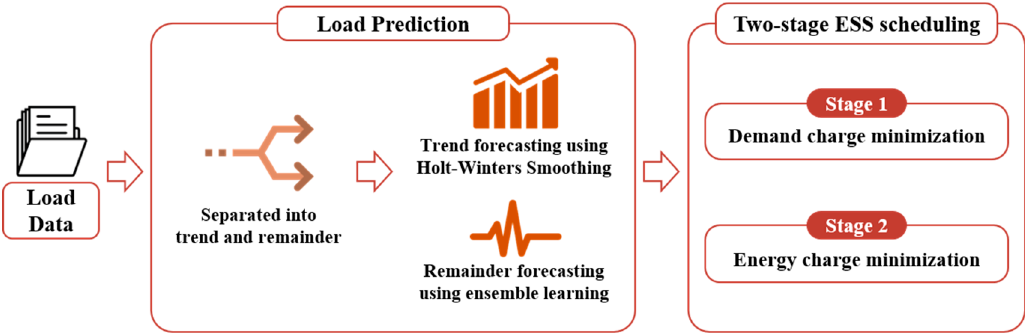
Figure 1. Methodology diagram flow.